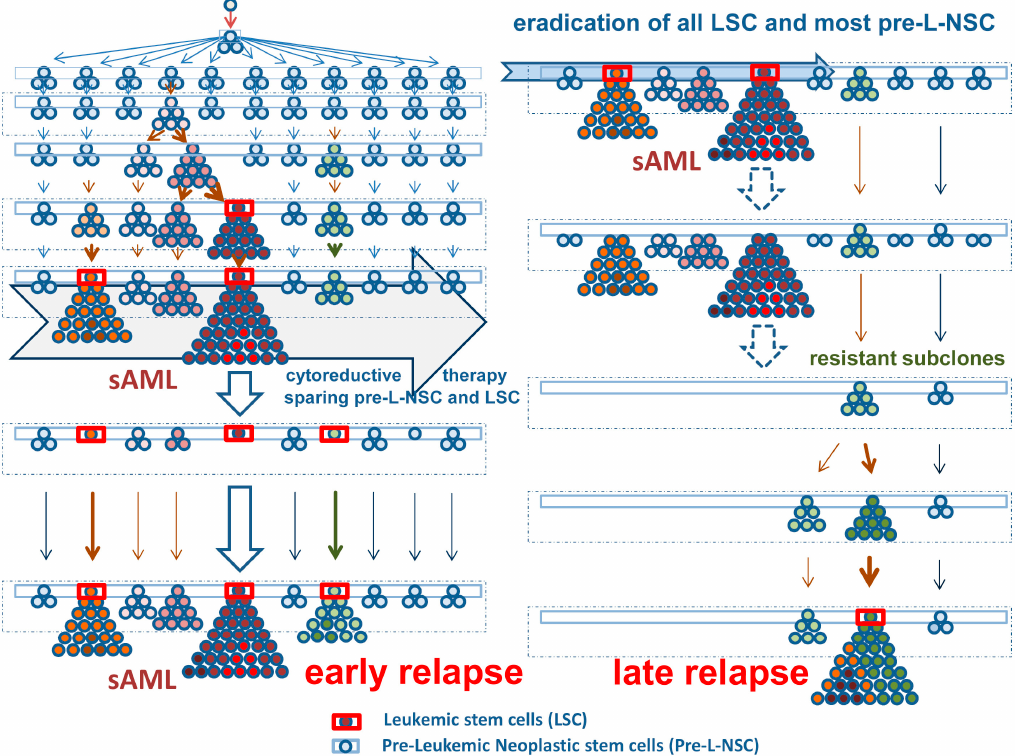
Figure 1. Development and diversification of leukemic stem cells in secondary acute myeloid leukemia (sAML). Left panel, upper part: An initial oncogenic event transforms a normal stem cell into a premalignant (preleukemic) neoplastic stem cell (Pre-L-NSC) (blue boxes). These cells or their daughter cells acquire early somatic mutations. Usually, these have low oncogenic potential (blue-colored cells) and are thus slowly cycling or dormant cells so that the mutation is not detectable. After some time, more daughter clones develop and the somatic lesions may be detected and classified as clonal hematopoiesis with indeterminate potential (CHIP). After several years or decades, one or more daughter clones and their stem cells expand and may replace normal hematopoiesis. At that time, some of the stem cell clones may have acquired disease-specific oncogenic driver lesions (red-colored cells). Still, these cells may be indistinguishable from normal cells by morphology and in functional terms. In a next step, one or more of the sub-clones acquire additional driver mutations or lose tumor suppressor genes. As a result, the stem cells are now cycling and the neoplastic process forms a visible overt myeloid neoplasm (red-colored prominent clones—upper left panel). In most instances, these neoplasms still behave as indolent driver-positive neoplasm for some time. However, unless treated, many of these conditions will finally transform into a secondary acute myeloid leukemia (sAML). At that time, long-term disease propagating cells are called leukemic stem cells (LSC—red boxes). Note that all of the Pre-L-NSC-derived clones are also still present and can be detected (as small-sized sub-clones) in an overt sAML. Left lower panel: Nonspecific cytoreductive (palliative) therapy (example: hydroxyurea) can suppress the growth of cycling stem and progenitor cells for some time but cannot eradicate any of the Pre-L-NSC or LSC. After a variable (usually short) time period, a relapse develops. Right panel: Most interventional therapies (intensive chemotherapy, targeted drugs, or stem cell transplantation) are able to eradicate most or all of the LSC and their progeny, but not all Pre-L-NSC. When all LSC are killed, the patient enters complete remission and operational cure. In these patients, the Pre-L-NSC may or may not be detected as minimal residual disease. These Pre-L-NSC may (or may not) produce a late relapse after several months or years. Although some of the early mutations (rarely even drivers) of the original sAML clone may be detected in such relapsing disease, the molecular aberration profiles usually differ substantially from the initial molecular make-up of the sAML clone.